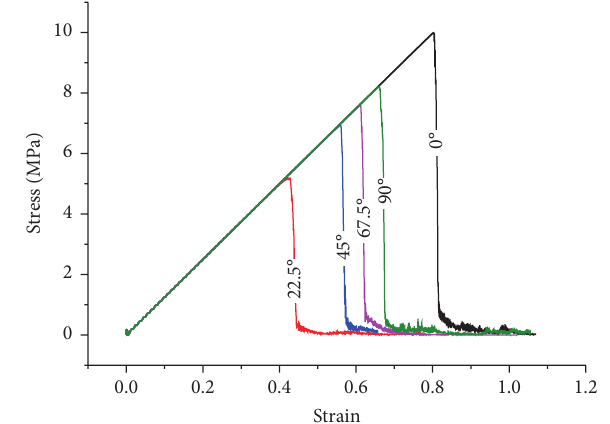
Figure 11: Stress-strain curves of FDEM simulated specimens in UCS tests under different inclined